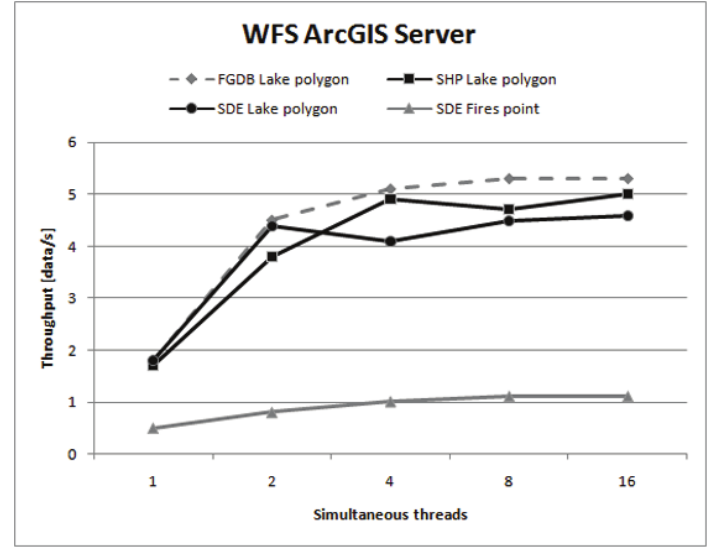
Figure 3: WFS ArcGIS Server tests